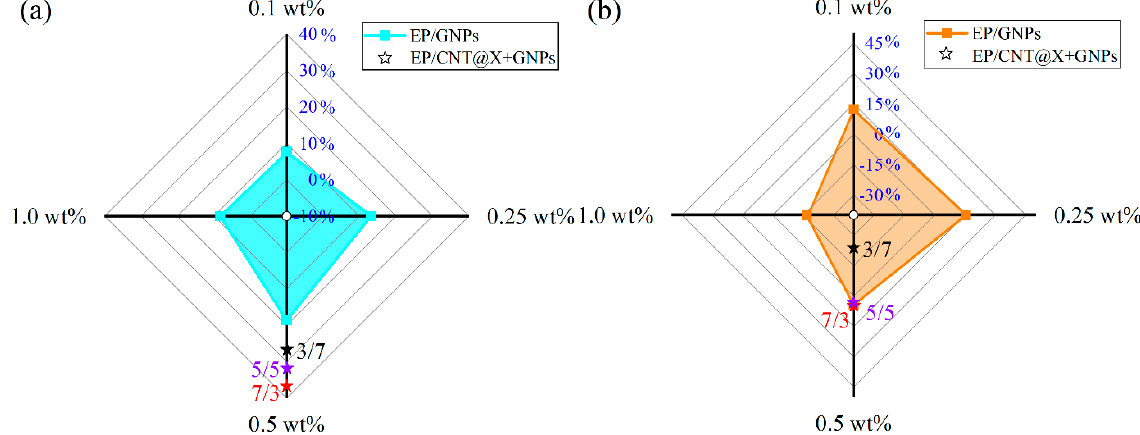
Figure 13. Radar plot for improved ( a ) dynamic compressive strength and ( b ) failure strain with respect to neat epoxy for different nanocomposite systems under a strain rate of 1000/s.